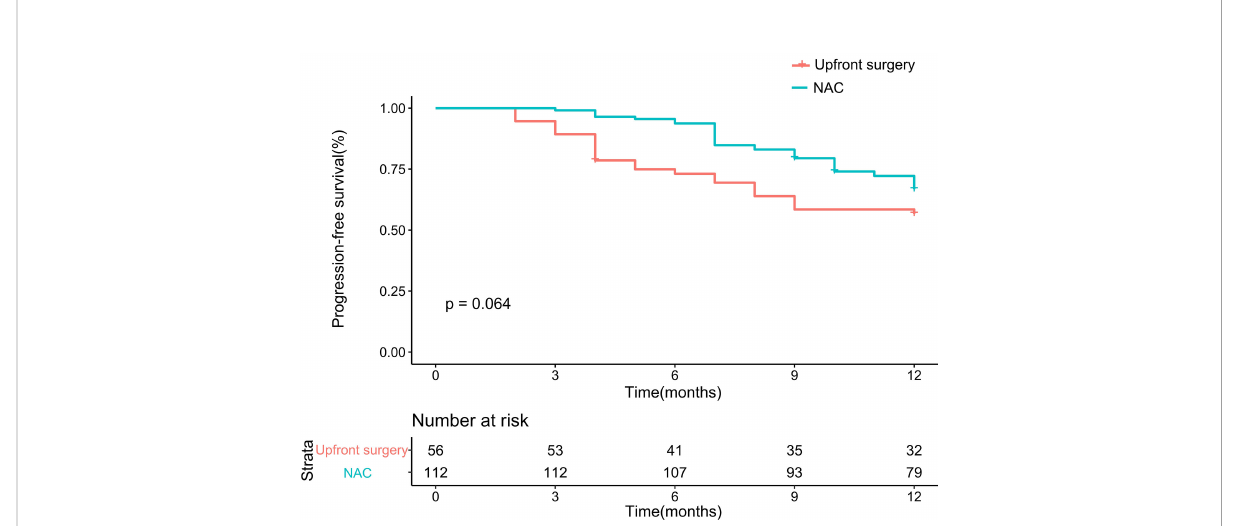
FIGURE 3 Kaplan-Meier curves for 1-year progression-free survival between upfront surgery and neoadjuvant chemotherapy groups after 1:2 Propensity Score Matching Analysis. NAC, neoadjuvant